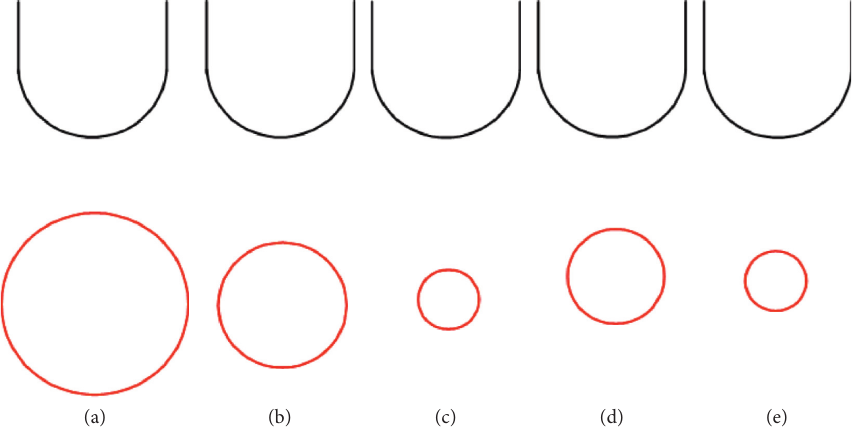
Figure 24: Description of spherical bubble morphological characteristics. (a) First maximum volume. (b) Spherical bubble. (c) First minimum volume. (d) Second maximum volume. (e) Second minimum volume.